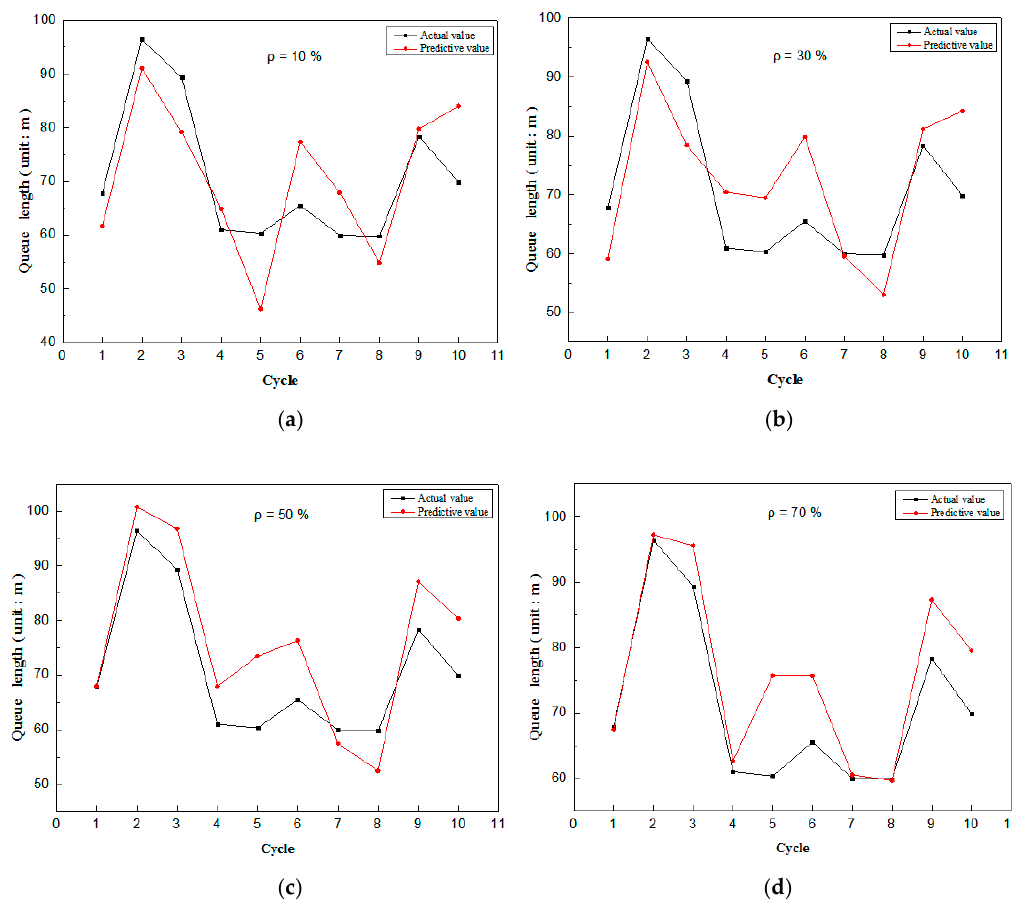
Figure 5. Shockwave-based queue length estimation results when penetration rate ρ = 10% ( a ), penetration rate ρ = 30% ( b ), penetration rate ρ = 50% ( c ) and penetration rate ρ = 70% ( d ).